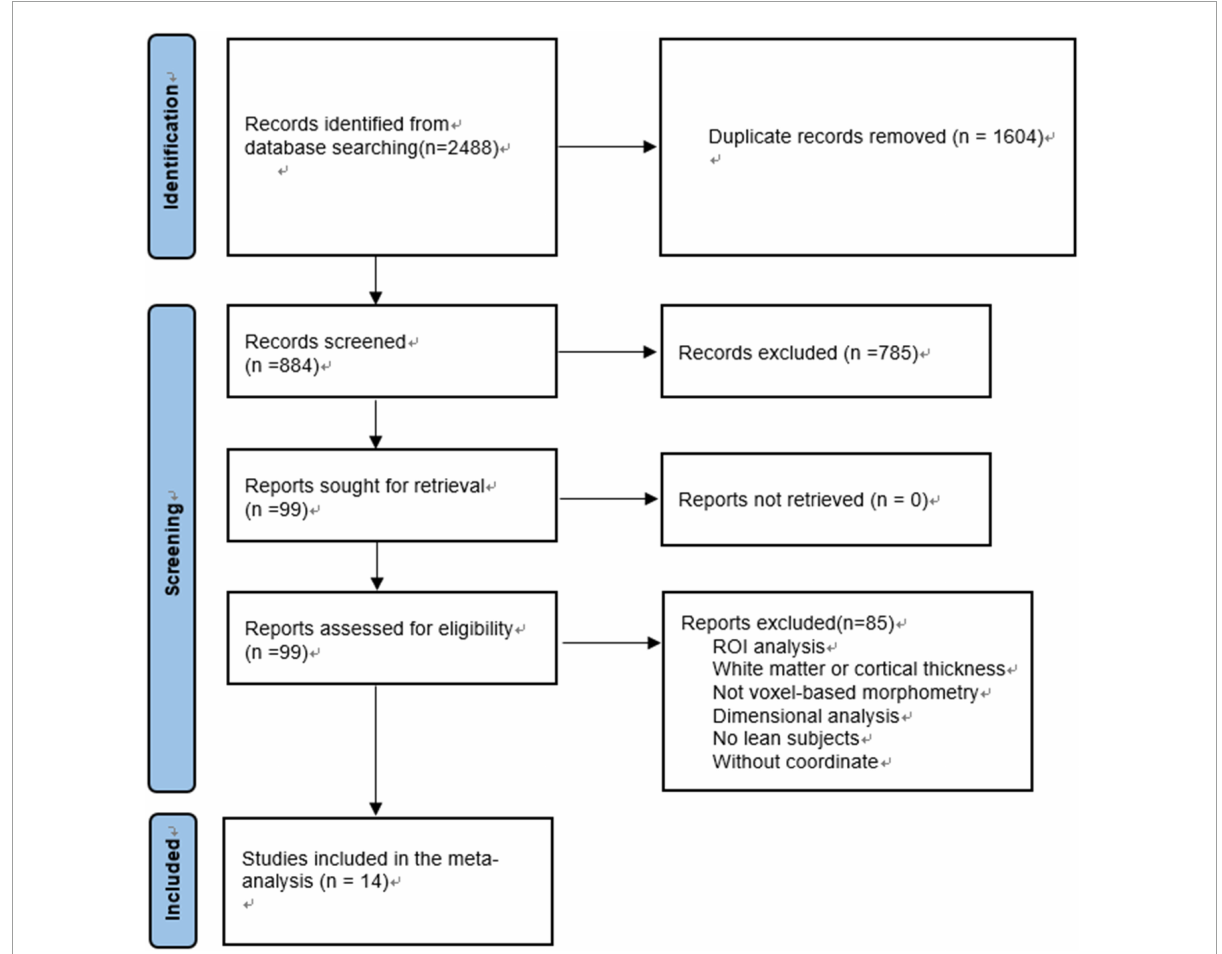
FIGURE1 Flowchart of the selection of VBM studies in subjects with overweight and obesity for